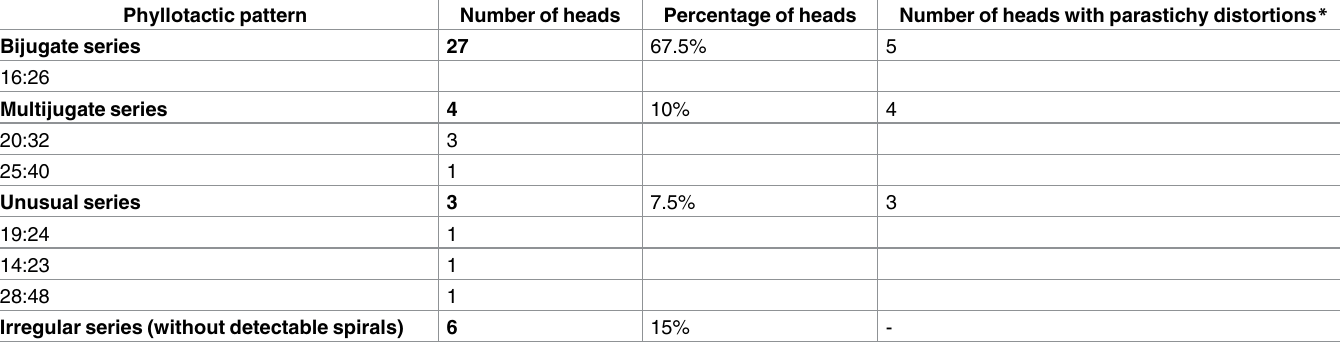
Table 1. Phyllotactic patterns in Dipsacus fullonum (n =